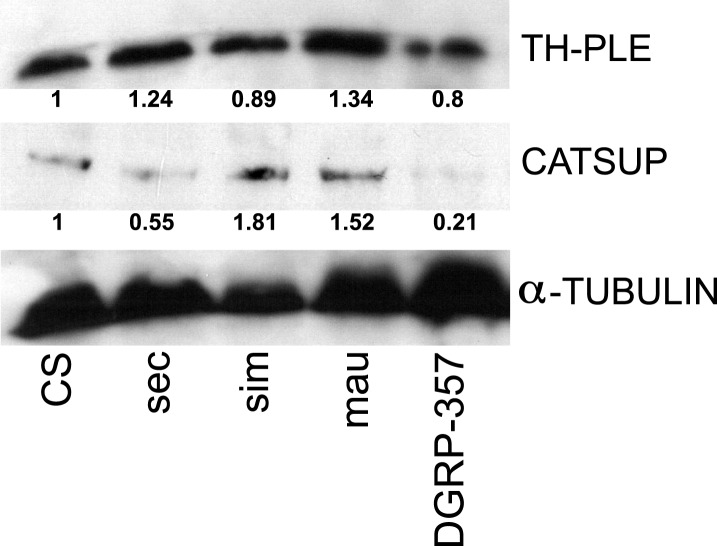
TH-PLE and CATSUP expression in Drosophila.Western blots of total protein whole-fly extracts for TH-PLE, CATSUP, and α-TUBULIN as a loading control in D. melanogaster Canton-S (CS), D. sechellia (14021–0248.31, sec), D. simulans (14021–0251.004, sim), D. mauritiana (14021–0241.01, mau) and D. melanogaster DGRP-357 (DGRP-357) fed a standard diet. The numbers under TH-PLE and CATSUP protein lanes indicate the relative protein levels (normalised to α-TUBULIN).